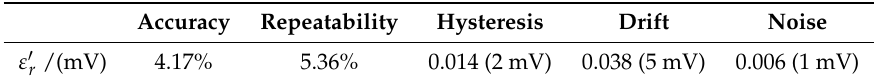
Table 3. Results of the performance evaluation of the second generation of the dielectric sensor.